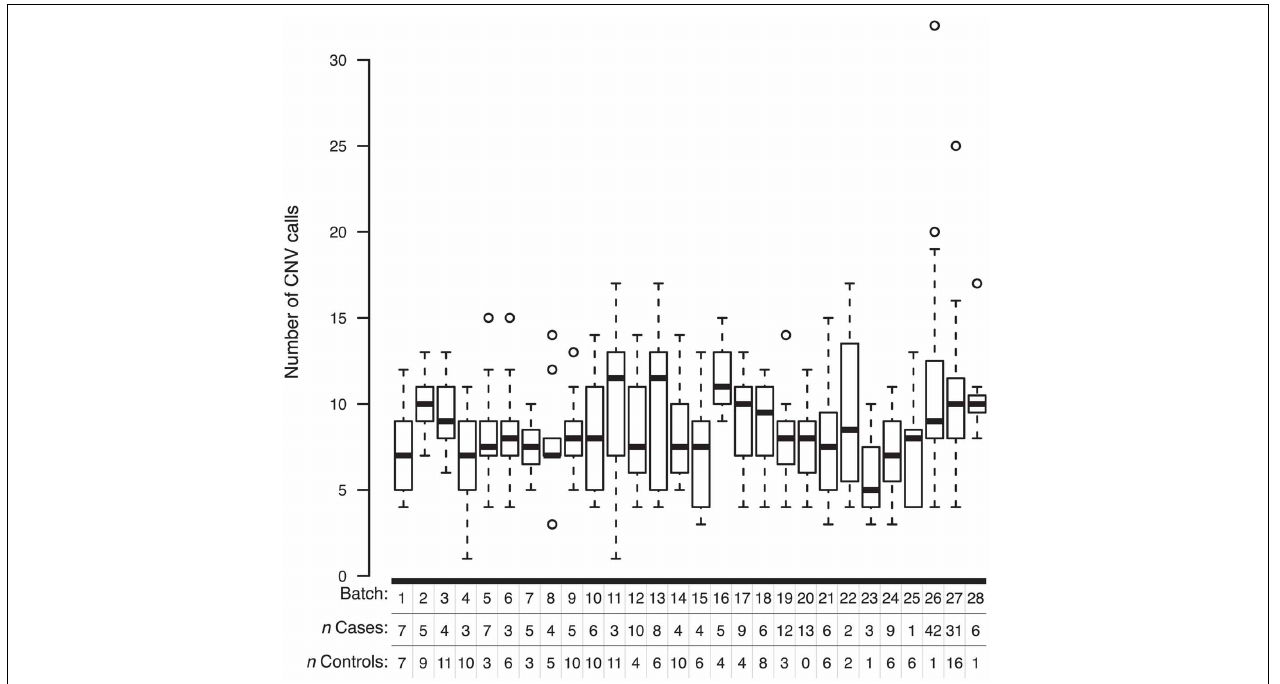
FIGURE 3 | Box-and-whisker plots of the number of CNV calls made within different experimental batches. Whole-genome SNP array genotyping was performed in 28 batches. Based on the final derived set of 3520 QC-filtered CNV calls, the interquartile range and median number of